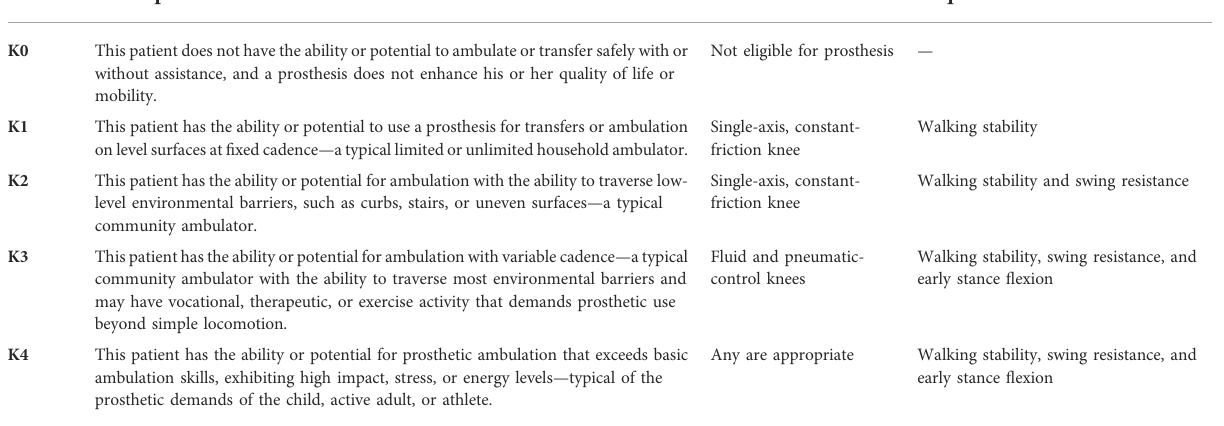
TABLE 1 Transfemoral amputation functional classi fi cation